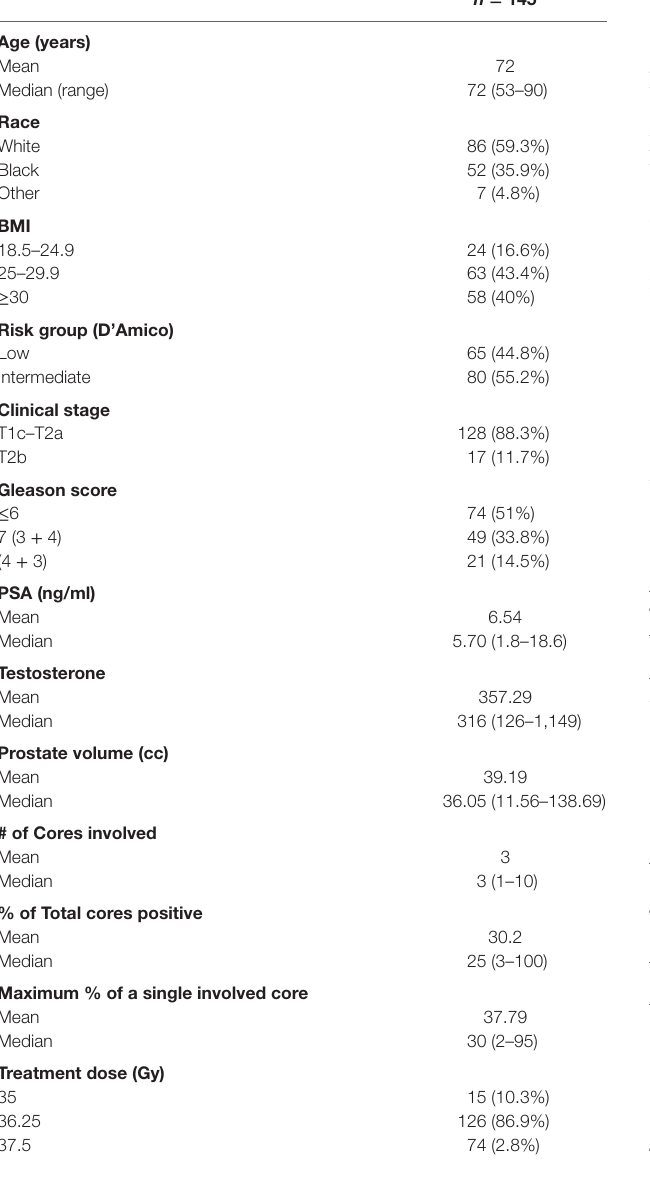
TaBle 1 | Patient, tumor, and treatment characteristics.